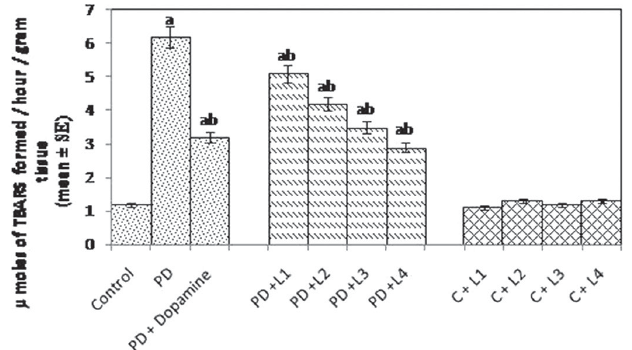
FIGURE 4 - Effect of luteolin on the lipid peroxidation in the brains of flies. [L1 = 25 µM; L2 = 50 µM; L3 = 75 µM; L4 = 100 µM; PD = PD flies; Dopamine = 10 -3 M]. The flies were allowed to feed on the diet supplemented with luteolin for 24 days and then assayed for lipid peroxidation. The values are the mean of 5 assays. [a - significant at p<0.05 compared to control; b - significant at p<0.05 compared to PD